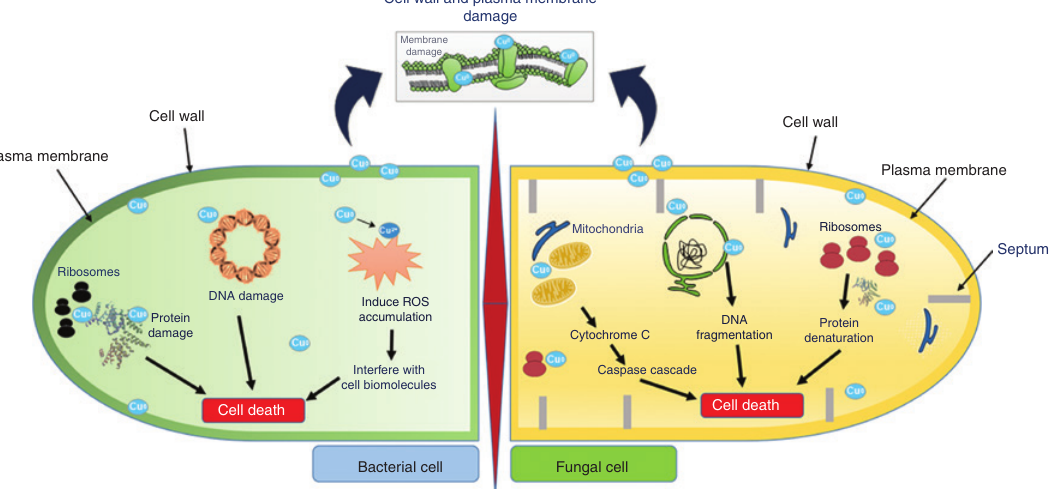
Figure 2: Schematic illustration for possible mechanism of CuNPs on microbes: CuNPs act on microbial cell wall and disturbs its components, which leads to membrane damage. Membrane damage decreases the electrochemical potential, which affects membrane integrity. In addition, CuNPs target DNA, interferes with protein synthesis, and cause damage leading to death of microbial